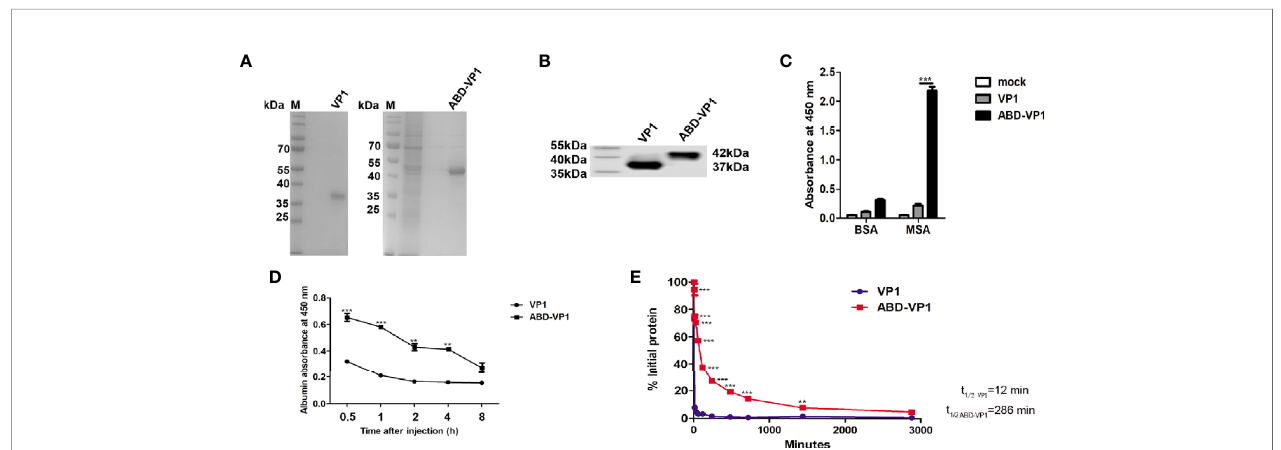
FIGURE 1 | Albumin-binding ability of ABD-VP1vaccine. (A) SDS-PAGE and (B) western blot analysis of the recombinant ABD-VP1 and VP1 proteins. (C) The binding abilities of ABD-VP1 and VP1 proteins to albumins were detected by ELISA assays. (D) Serum complex of ABD-VP1 with albumin was detected by ELISA assays. (E) The serum half-lives of ABD-VP1 and VP1 vaccines. VP1 and ABD-VP1 proteins were injected subcutaneously into mice, sera were taken at indicated time points for VP1 amount detection by ELISA assays. The level of serum VP1 protein at 5 min after injection was uniformly quanti fi ed as 100%. Individual experiment was repeated 3 times. *P < 0.05; **P < 0.01; ***P <